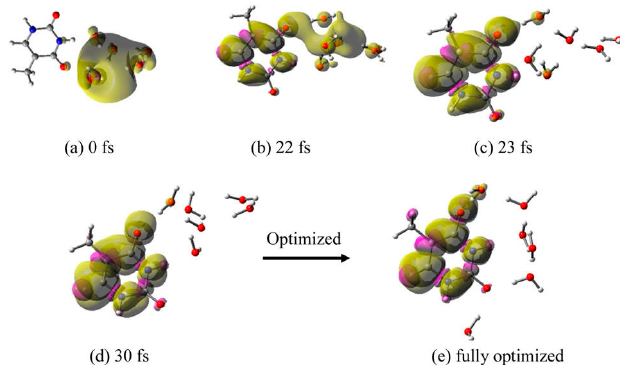
Figure 4. Total spin density plot of T–6H 2 O • − at different times during MD simulation: ( a ) 0 fs (initial optimized starting structure for simulation), ( b ) 22 fs, ( c ) 23 fs, ( d ) 30 fs, and ( e ) fully optimized structure. Structure ( e ) is stabilized by -0.9 eV over structure ( a ). Reprinted with permission from reference [72]. Copyright, 2016, American Chemical Society.